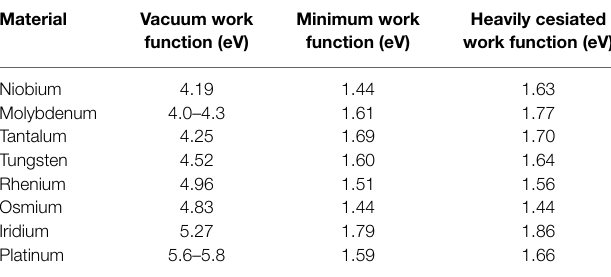
TABLE 2 | Work functions of various metal surfaces in vacuum and in cesium vapor with the minimum work function under optimized cesium coverage and for surfaces with increased cesium